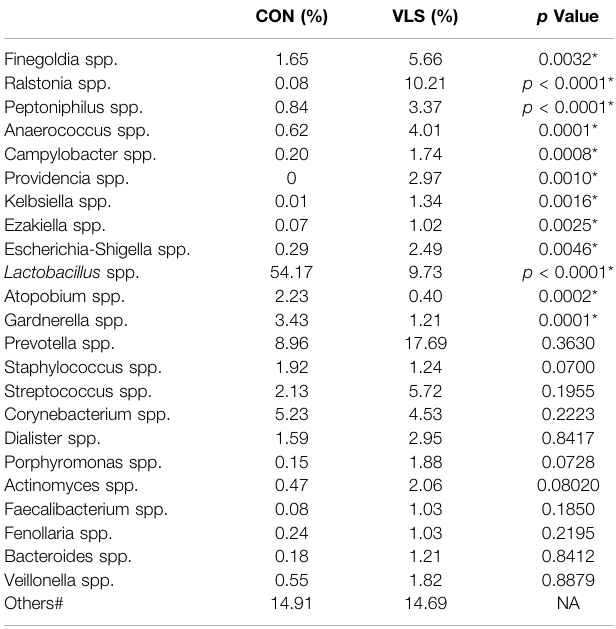
Frontiers in Cell and Developmental Biology |